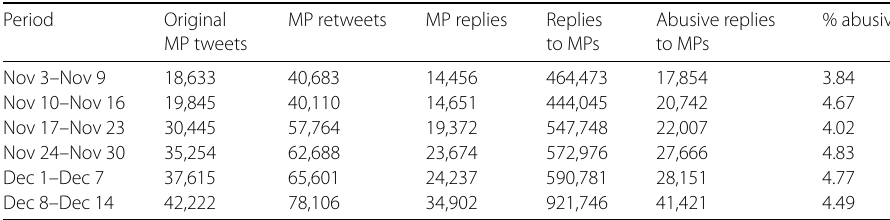
Abusive replies % abusive to MPs to MPs